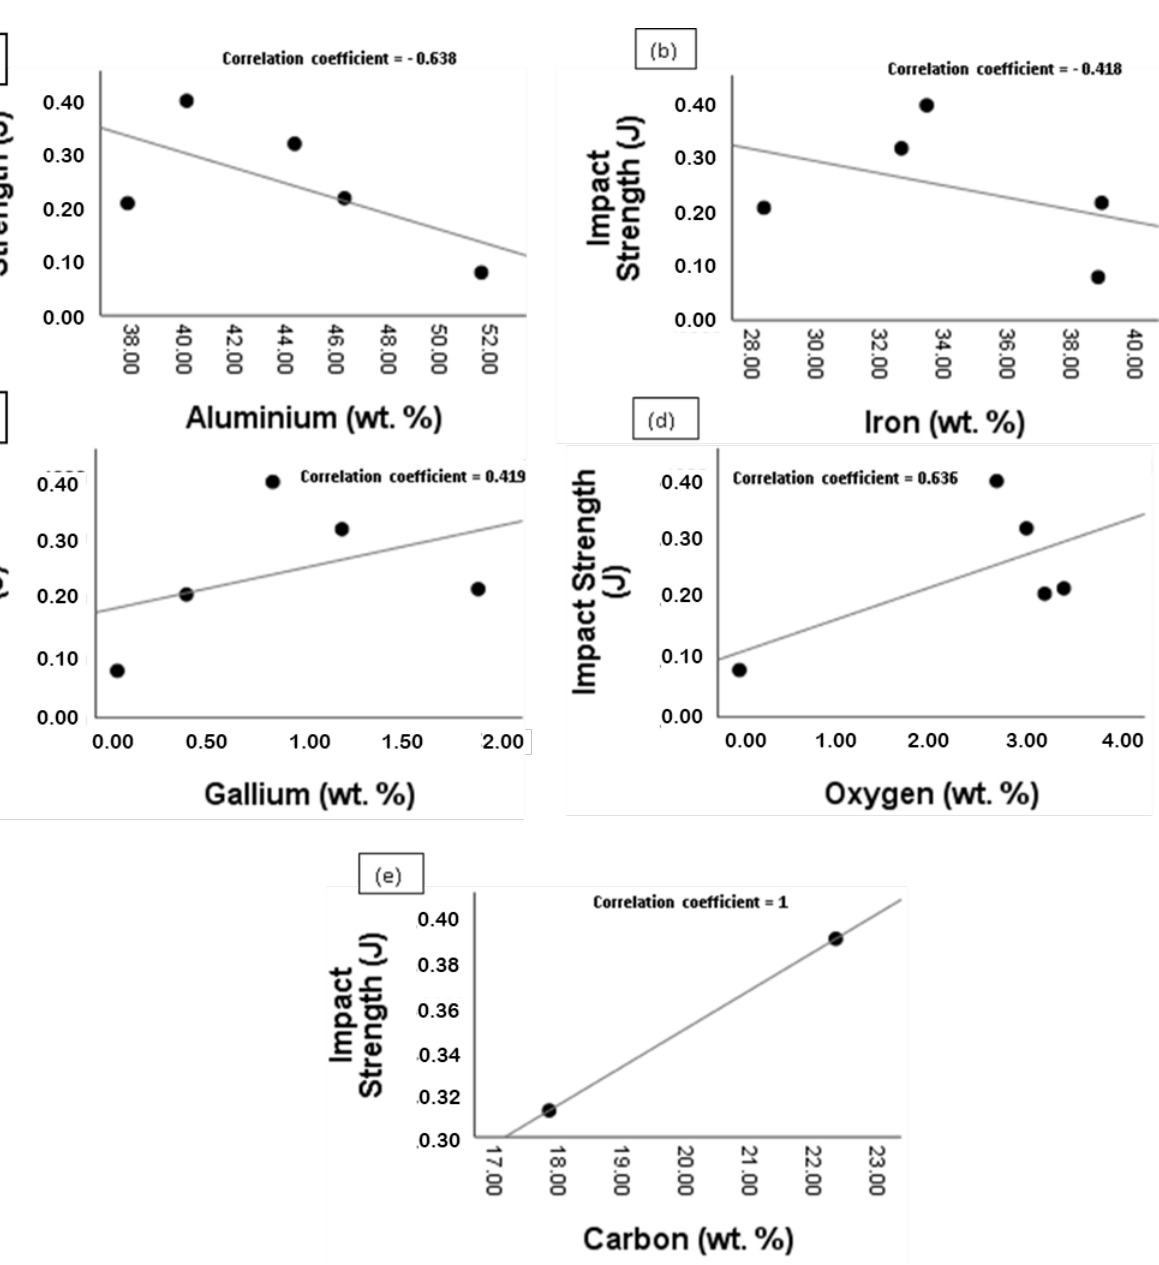
Figure 13. Scatter plot of the impact strength against the elemental composition (wt.%) of the reaction layer: ( a ) Impact strength against Al; ( b ) Impact strength against Fe; ( c ) Impact strength against Ga; ( d ) Impact strength against O; ( e ) Impact strength against C.